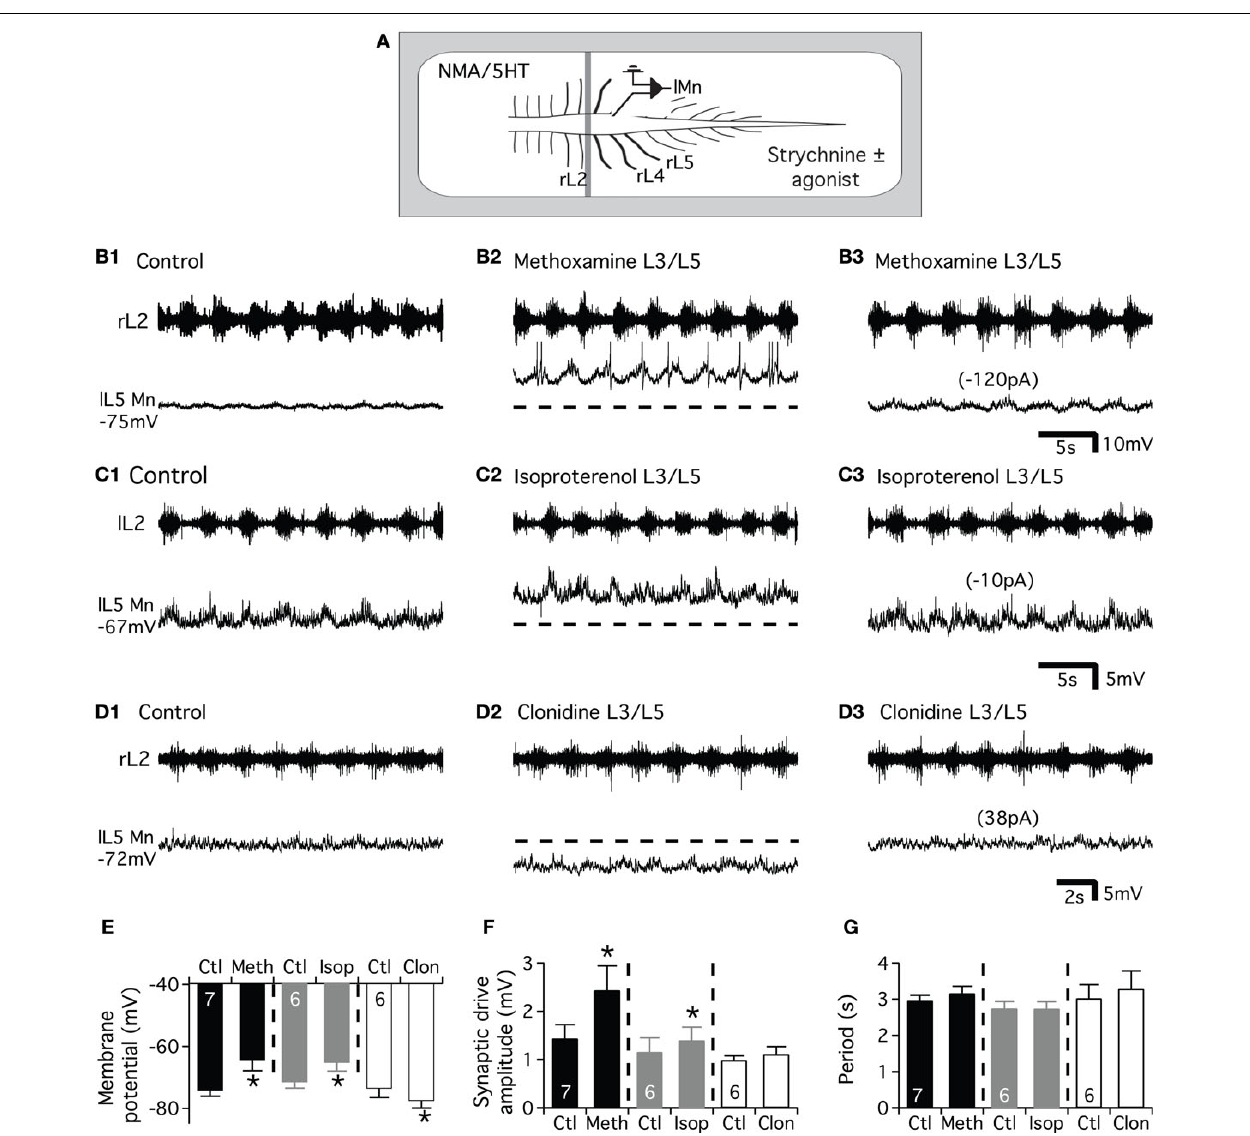
FIGURE 7 | Effects of the NAergic agonists on the glutamatergic synaptic drive. (A) Schema of the experimental procedure. NMA/5HT was added to the saline superfused on the rostral compartment to elicit fi ctive locomotion recorded extracellularly from the L2 ventral roots. Strychnine was bath applied alone or in combination with one of the agonist on the caudal compartment of the spinal cord and motoneurons were recorded in the left part of the cord. Representative motoneurons recorded from the right or left L5 segment (rL5 or lL5) in control condition (B1,C1,D1) and in the presence of methoxamine (B2) ,